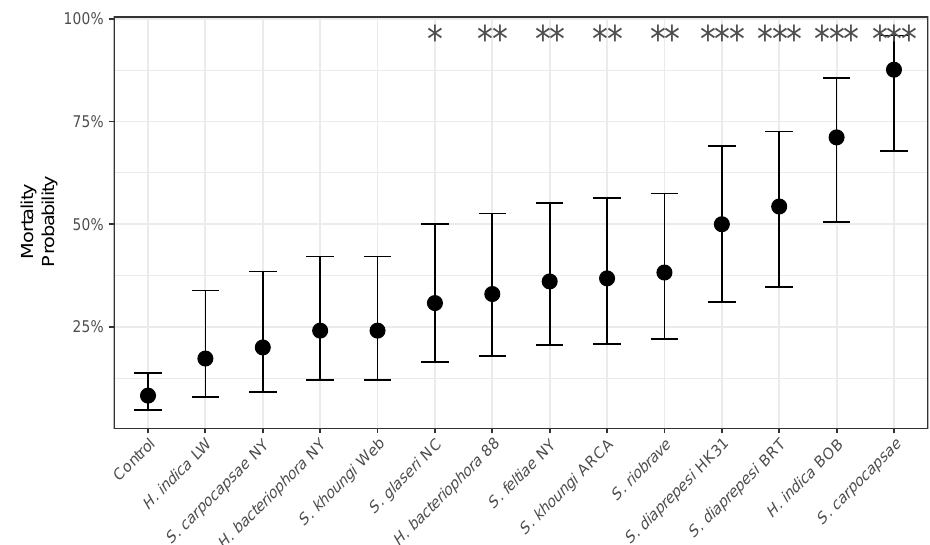
Figure 3. Probability of C. sayi mortality resulting from exposure to entomopathogenic nematode strains. H. bacteriophora NY and S. feltiae NY were the strains used in the field and microcosm trials. Mortality probability is calculated as of four days post inoculation. Points and errorbars denote mean and 95% confidence intervals, respectively. Asterisks denote significant differences at p < 0.05 (*), p < 0.01 (**), and p < 0.001 (***) compared to controls, not among strains.